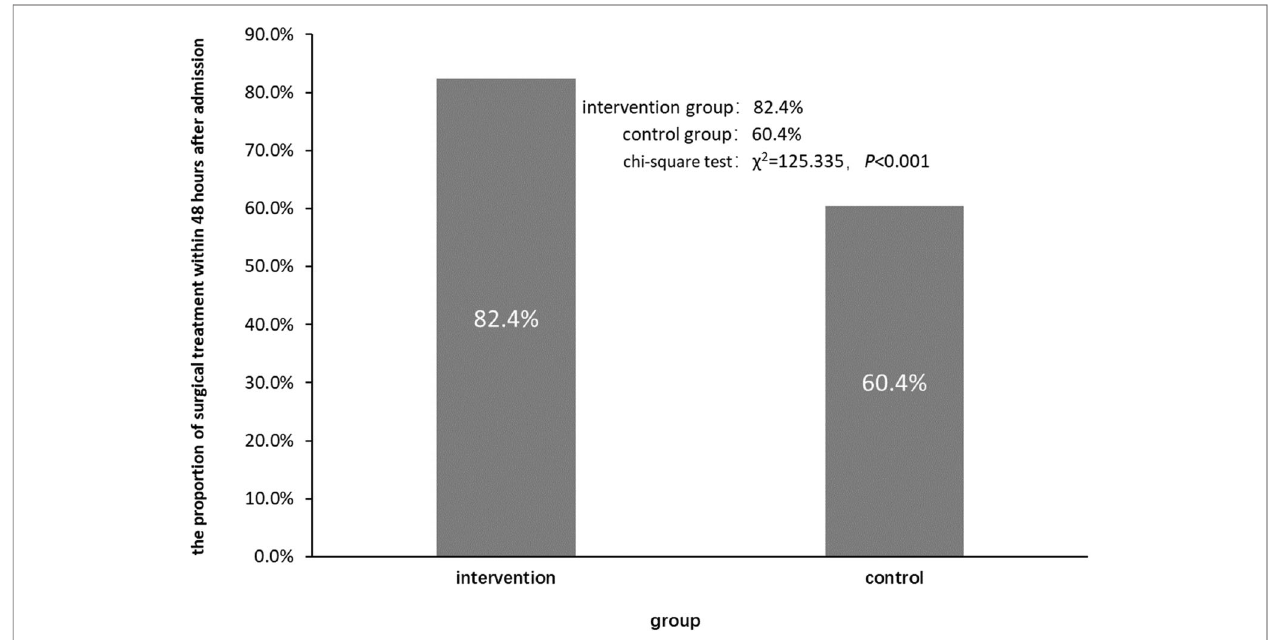
FIGURE 3 | Comparison of the proportion of surgical treatment within 48 h after admission between the two groups.